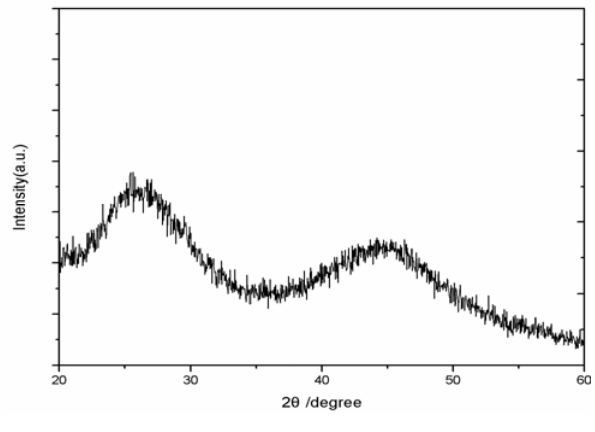
Figure 6. XRD pattern of the CdSe quantum dots synthesized at freezing